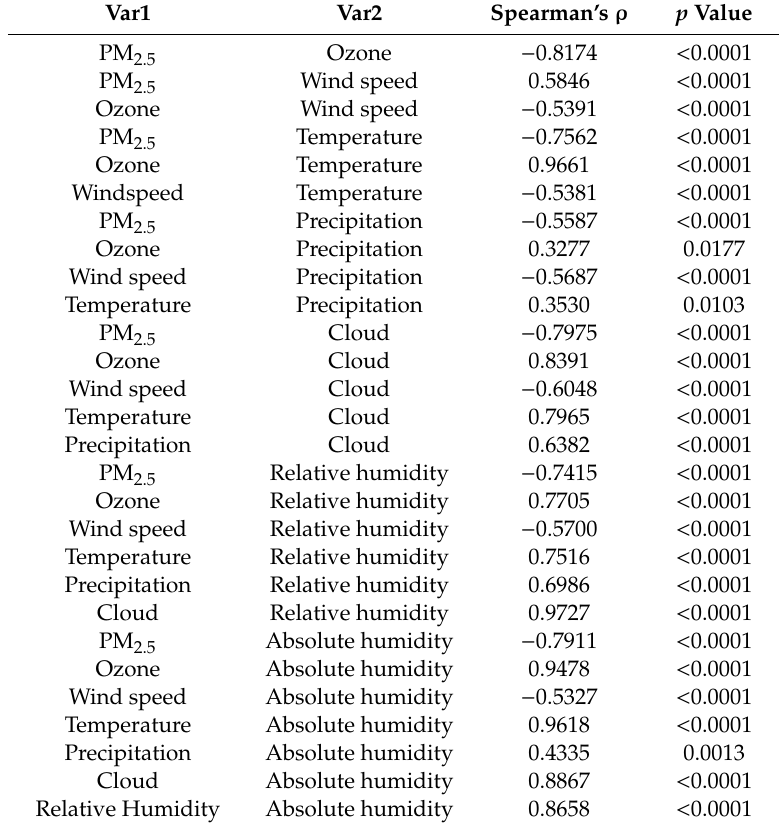
Table 2. Pairwise Spearman correlation of selected pollutants and meteorological factors. Var1 Var2 Spearman’s